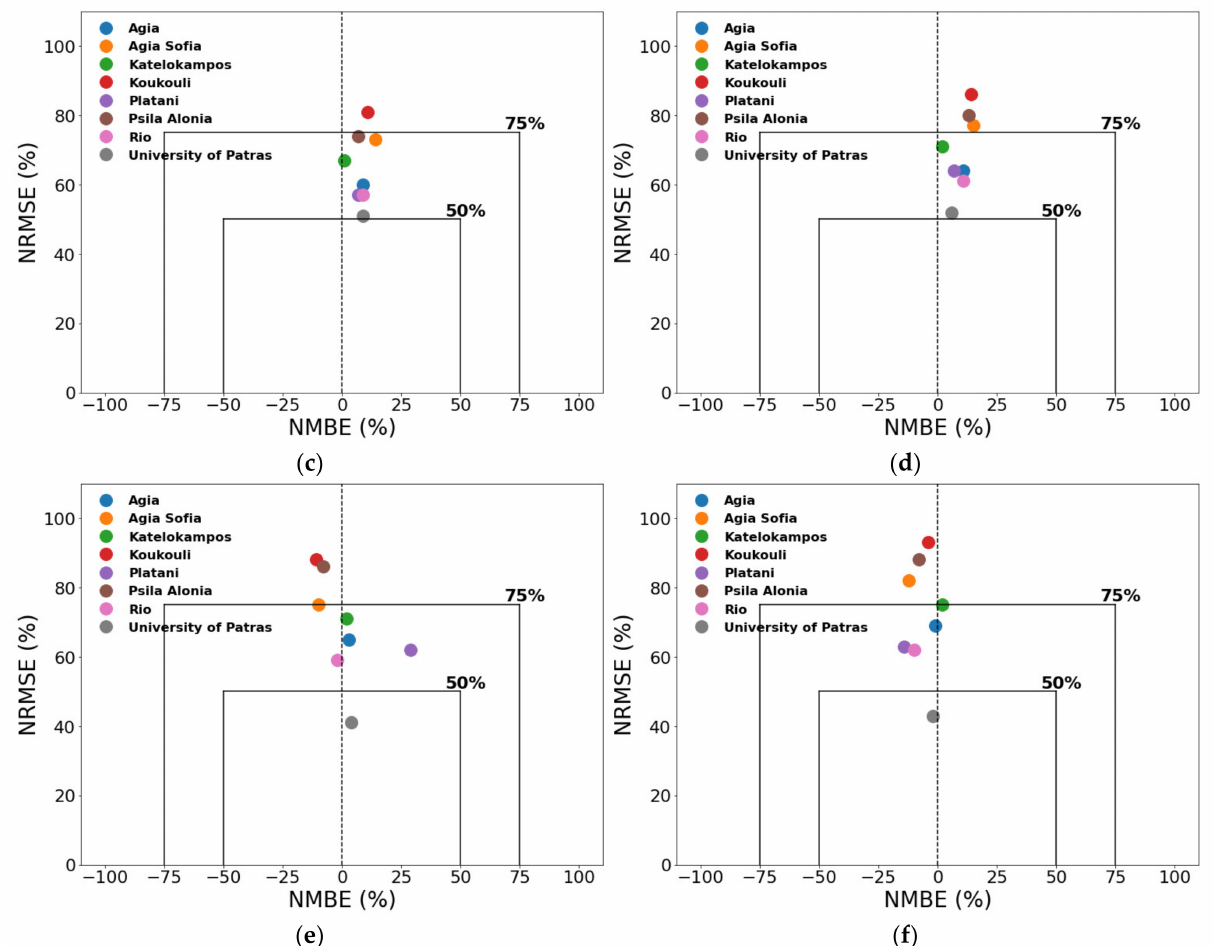
Figure 11. Soccer plots for PM levels over all stations for ( a , b ) CAMS, ( c , d ) AnEn, ( e , f ) LSTM forecasts for PM2.5 ( left ) and PM10 ( right